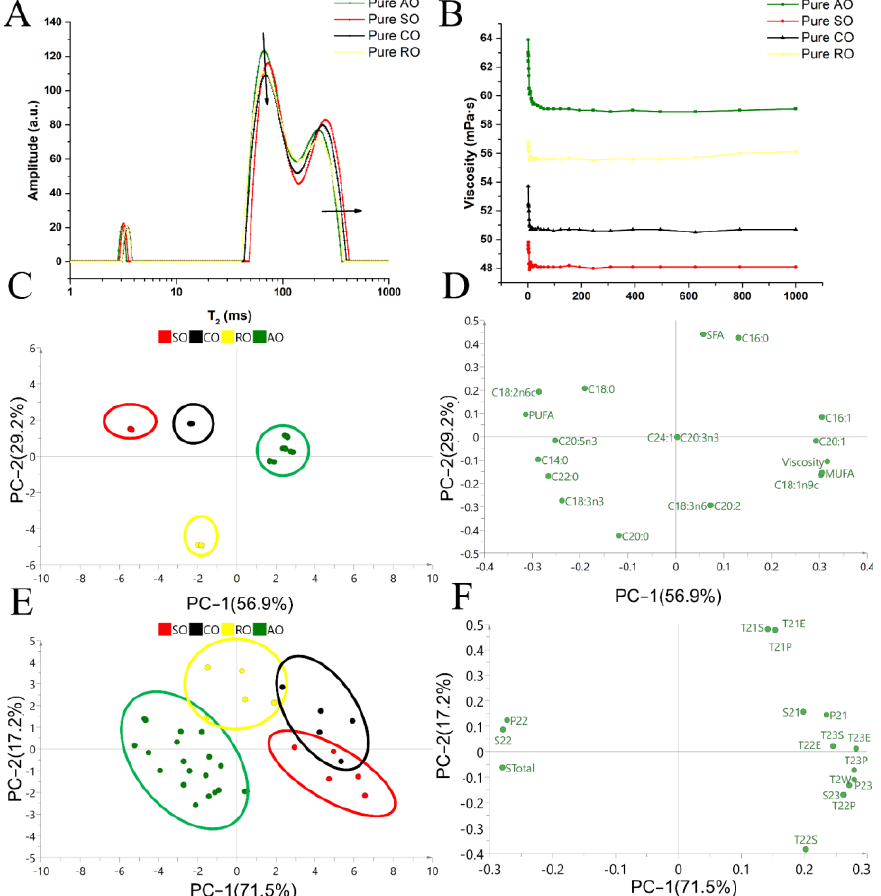
Figure 5. Analysis of fatty acids’ composition and viscosity of AO, SO, CO and RO to explain their differences in LF-NMR signals: ( A ) indicates T 2 distribution of each pure oil; ( B ) indicates the vis- cosity of each pure oil; ( C , D ) indicate the PCA score plot and loading plot of pure oils based on data of fatty acid composition and viscosity; ( E , F ) indicate the PCA score plot and loading plot of four pure oils based on T 2 parameters of LF-NMR profiles.